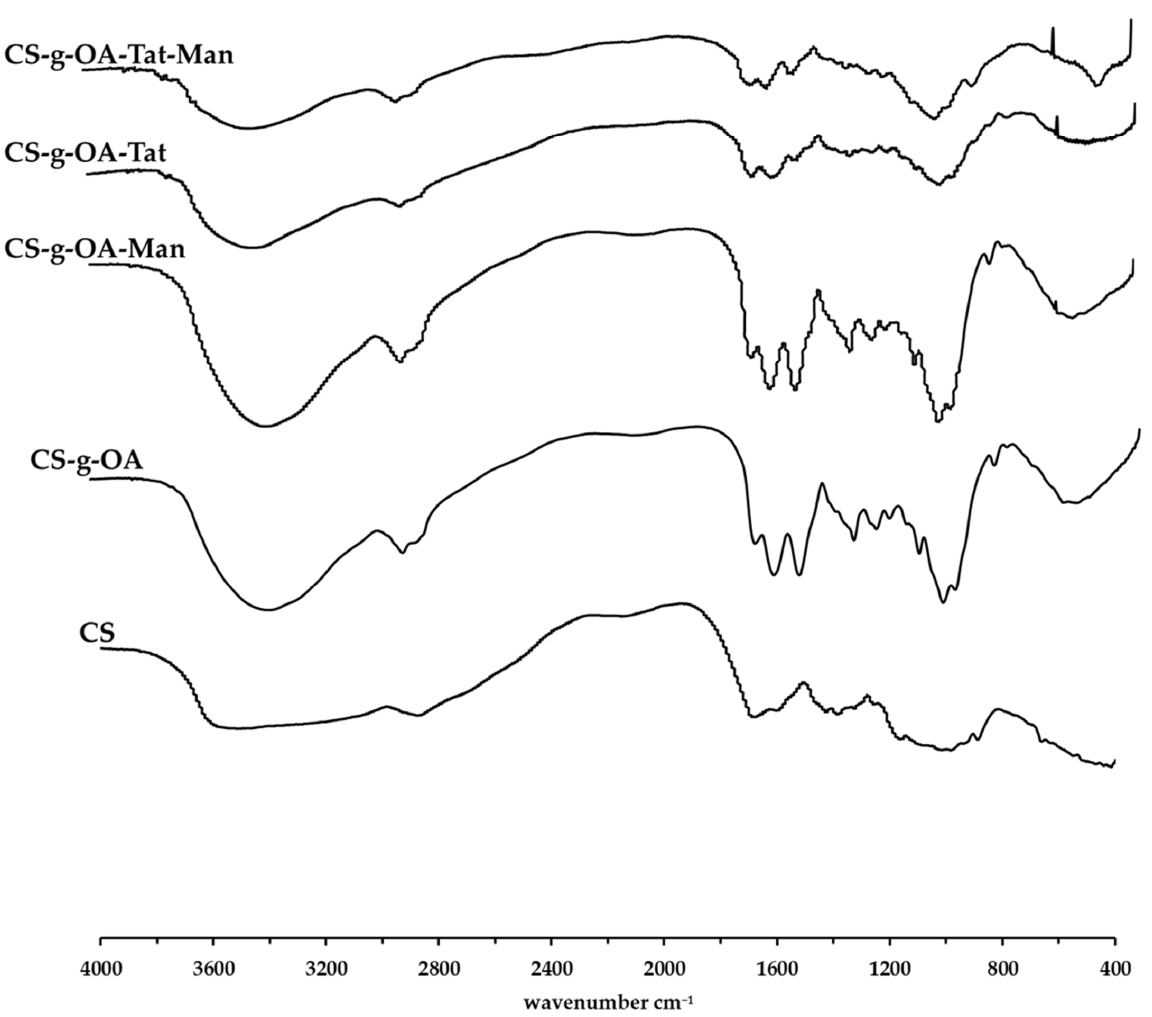
Figure 2. FT-IR spectra of CS and synthesized OA-g-CS, OA-g-CS-Man, OA-g-CS-Tat, and OA-g- CS-Man-Tat conjugates. Man-Tat